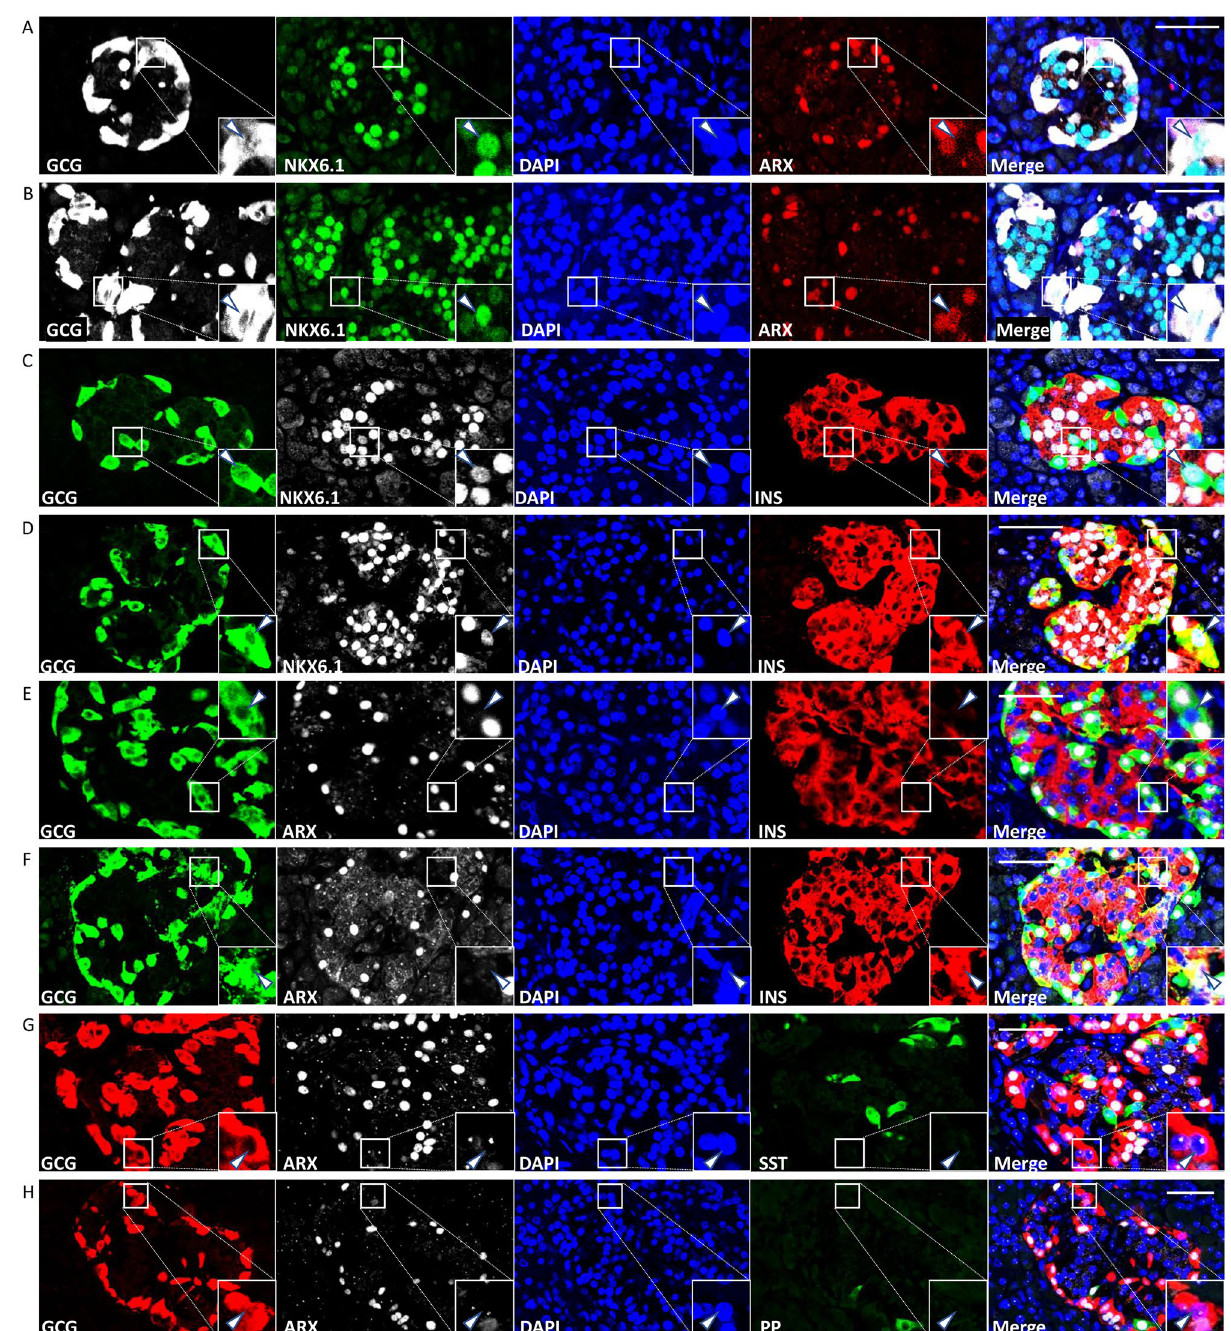
Figure 3. Representative images of islet immunostaining of an NGT female in her 50 s photographed under a laser scanning confocal microscope. ( A ) Triple immunostaining of GCG (white), NKX6.1 (green), and ARX (red). White arrowhead shows ARX-negative NKX6.1 + /GCG + cell. ( B ) Triple immunostaining of GCG (white), NKX6.1 (green), and ARX (red). White arrowhead shows ARX-positive NKX6.1 + /GCG + cell. ( C ) Triple immunostaining of GCG (green), NKX6.1 (white), and INS (red). White arrowhead shows INS- negative NKX6.1 + /GCG + cell. ( D ) Triple immunostaining of GCG (green), NKX6.1 (white), and INS (red). White arrowhead shows INS-positive NKX6.1 + /GCG + cell. ( E ) Triple immunostaining of GCG (green), ARX (white), and INS (red). White arrowhead shows INS-negative ARX − /GCG + cell. ( F ) Triple immunostaining of GCG (green), ARX (white), and INS (red). White arrowhead shows INS-positive ARX − /GCG + cell. ( G ) Triple immunostaining of GCG (red), ARX (white), and SST (green). White arrowhead shows SST-negative ARX − / GCG + cell. ( H ) Triple immunostaining of GCG (red), ARX (white), and PP (green). White arrowhead shows PP-negative ARX − /GCG + cell. GCG glucagon, NKX6.1 NK homeobox 6.1, INS insulin, ARX aristaless-related homeobox, SST somatostatin, PP pancreatic polypeptide, DAPI 4 ′ ,6-diamidino-2-phenylindole. Bars = 50